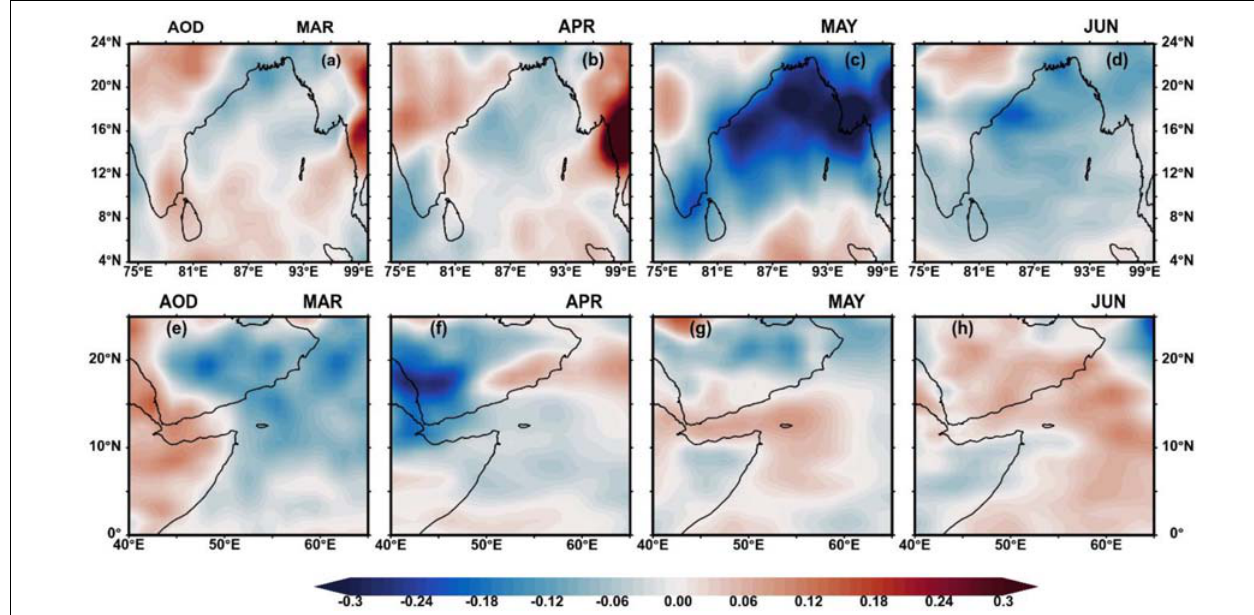
FIGURE 5 | Difference (pandemic – pre-pandemic) in aerosol optical depth over the BoB (A–D) and WAS (E–H) .